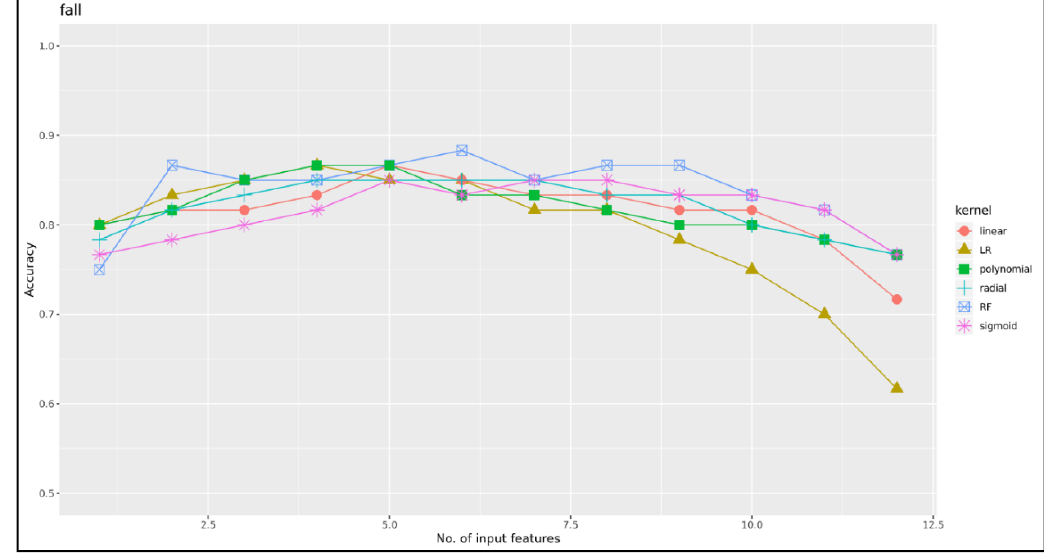
Figure 5. Kernel function of support vector machine.